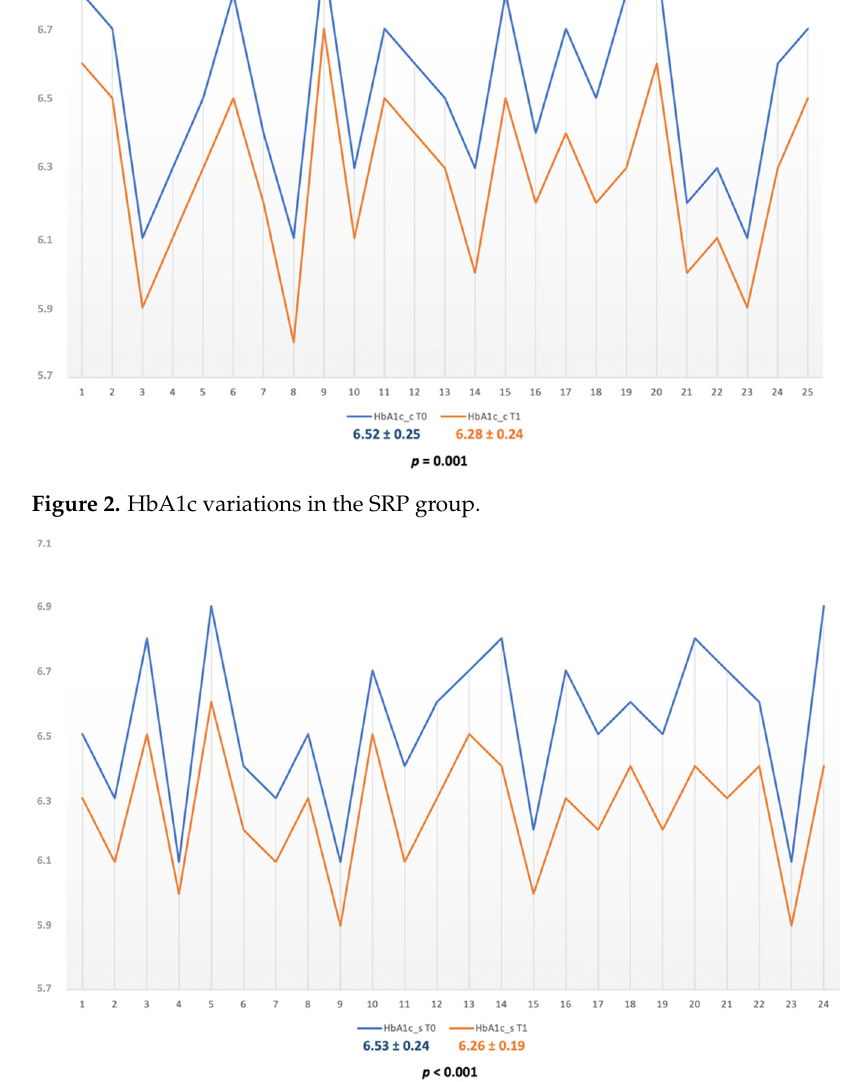
Figure 3. HbA1c variations in the SRP + aPDT group.